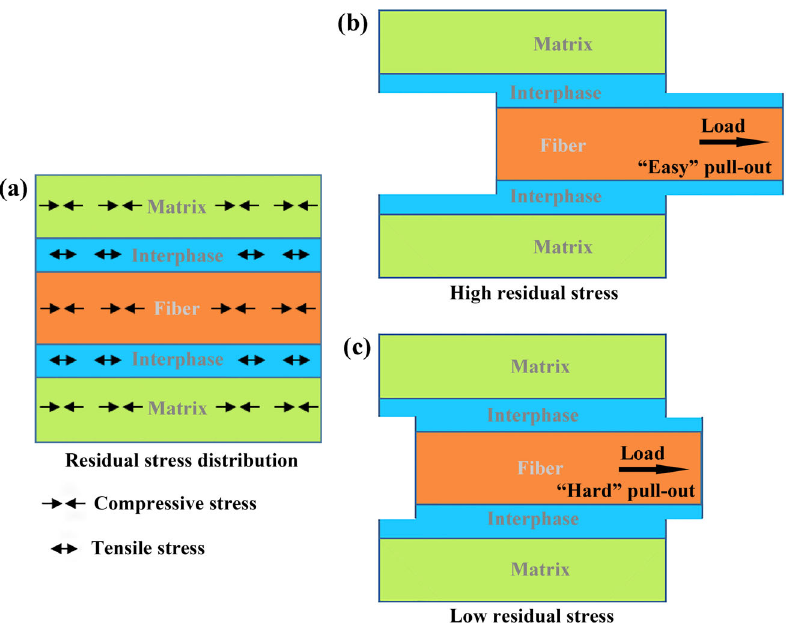
Fig. 6 Schematic of (a) residual stress distribution in SiC f /SiC and (b, c) mechanical behaviors under low and high residual stresses.